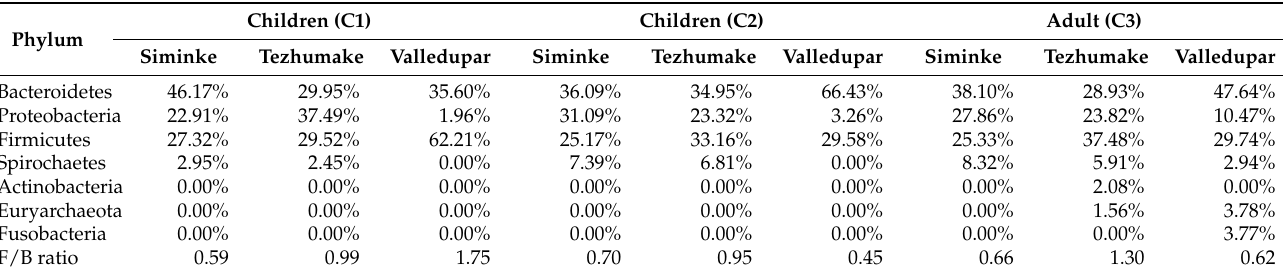
Table A8. Phylum distribution through the age groups for the three